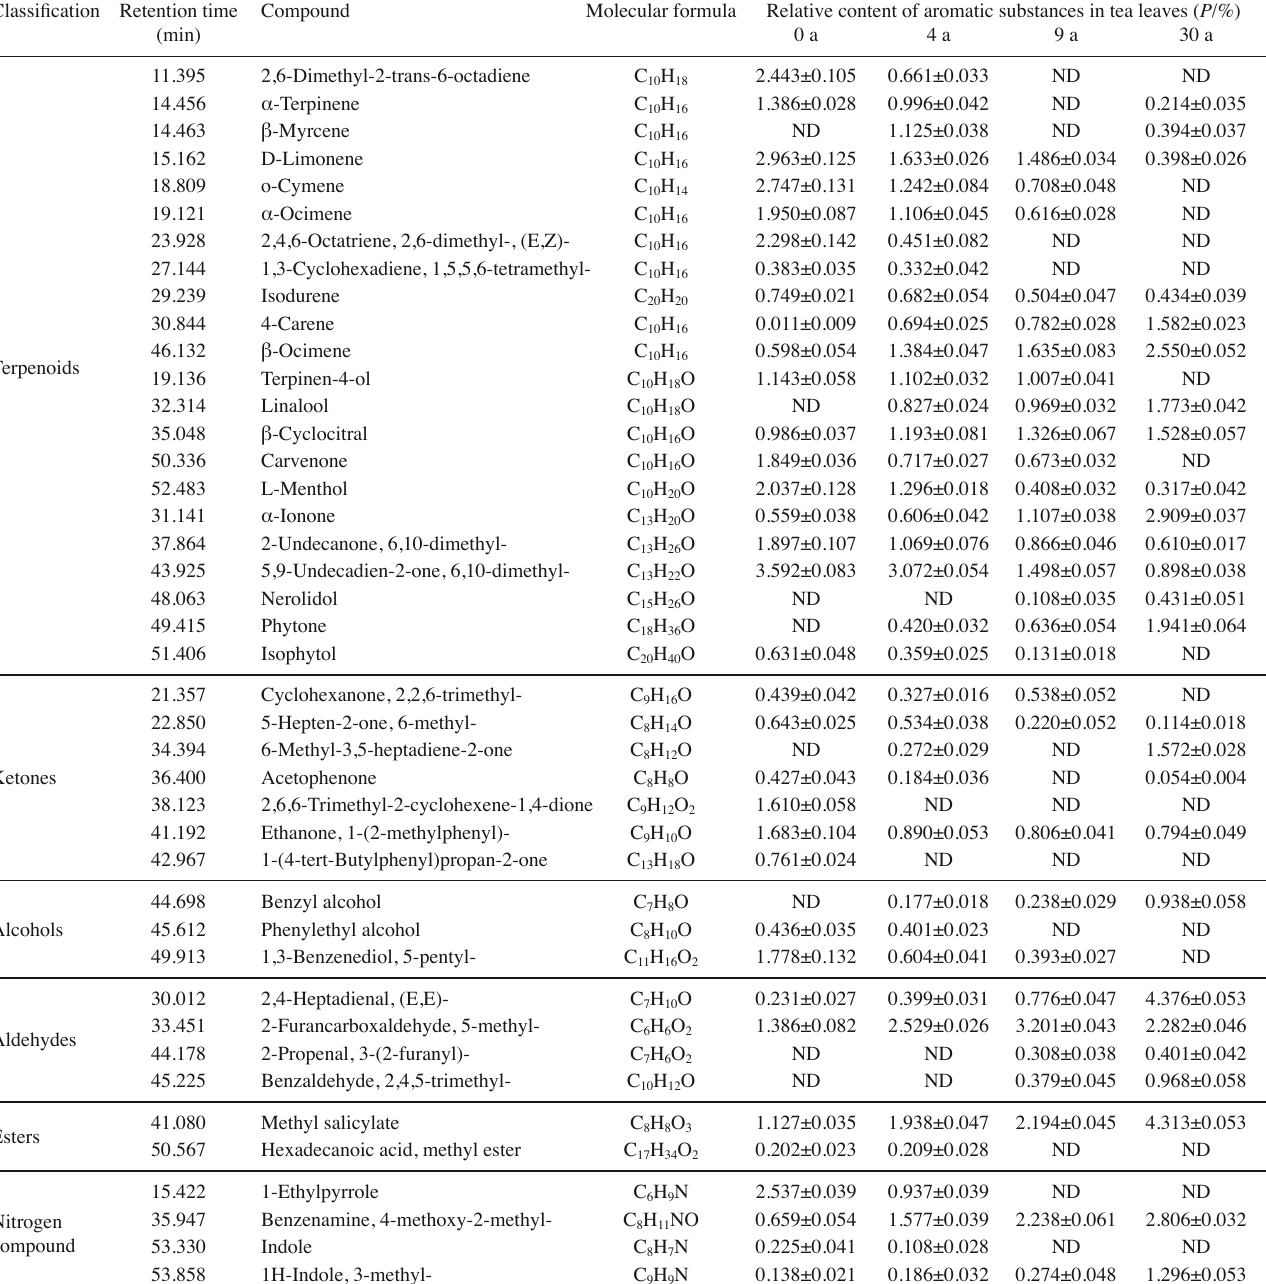
Tab. 3: Analysis of aromatic substances in tea leaves by GC-MS Classification Retention time